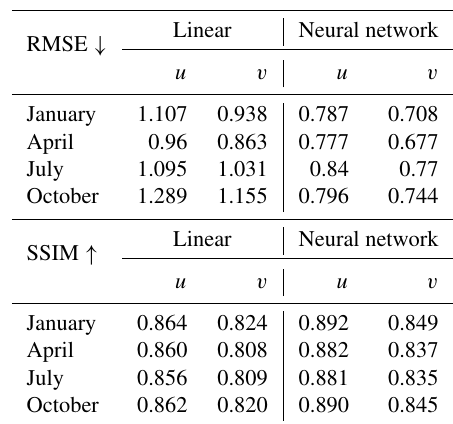
Table 2. RMSE and mean SSIM of the validation data set for lin- ear and neural network interpolation, using model4 . Considering the RMSE, the neural network interpolation is at least 19% more accurate compared to the linear